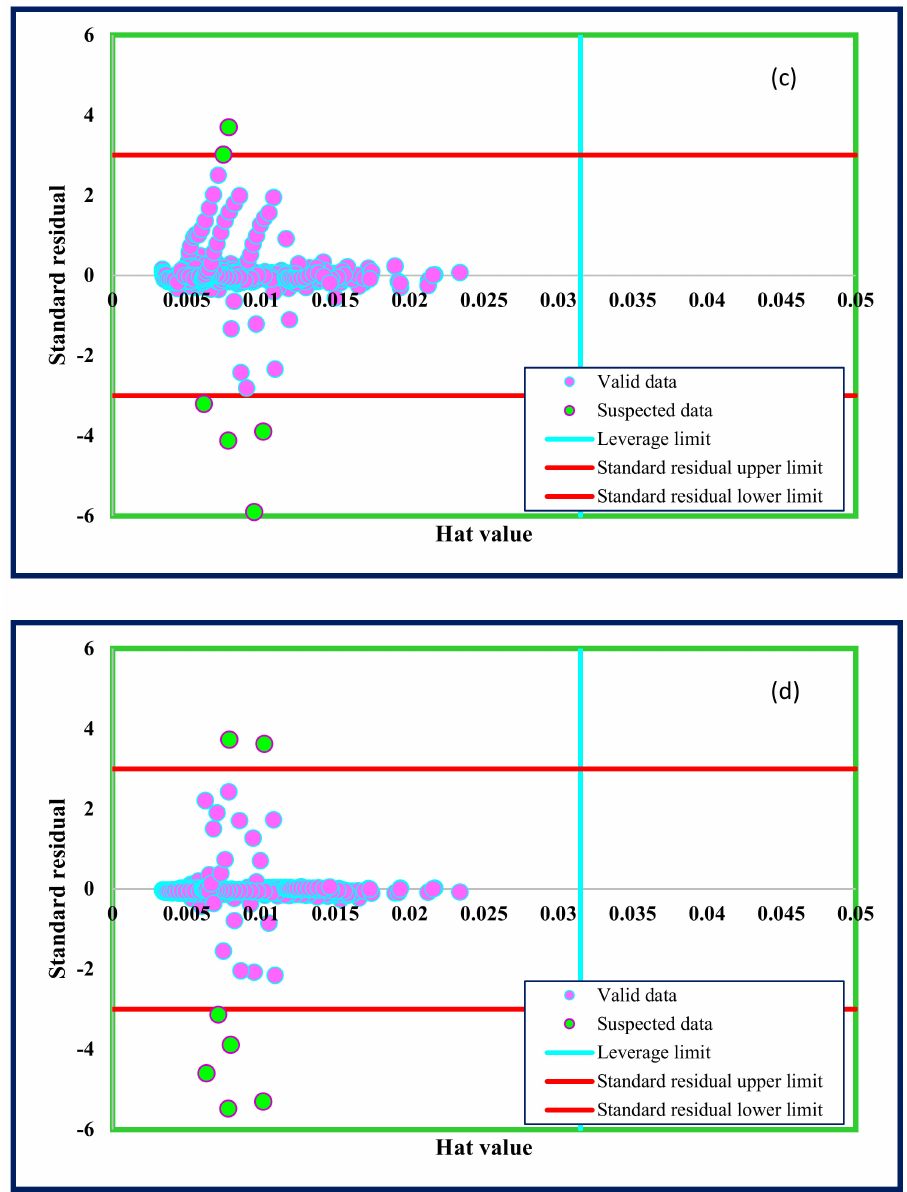
Figure 6. The detection of outlying data for the di ff erent models: ( a ) ANFIS, ( b ) MLP–ANN, ( c ) RBF–ANN, and ( d )